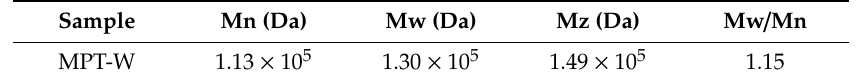
Figure 2. FT-IR, monosaccharide composition and HPGPC analysis. ( A ) FT-IR; ( B ) GC-MS of standard samples; ( C ) GC-MS of MPT-W; ( D ) HPGPC. FT-IR: Fourier transform infrared spectroscopy, HPGPC: high performance gel permeation chromatography, GC-MS: gas chromatography-mass spectrometry. Table 1. Mw, Mn and Mz of